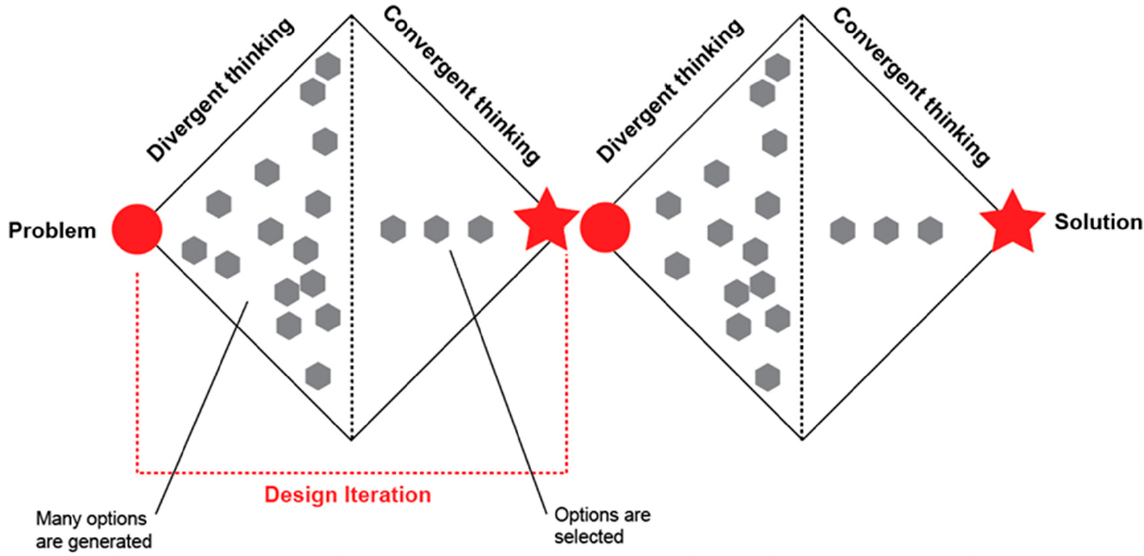
Figure 1. Schematic diagram of the Double Diamond design process, adapted from [36]. The problem, identified at the beginning of the design process, is investigated through divergent and convergent thinking.